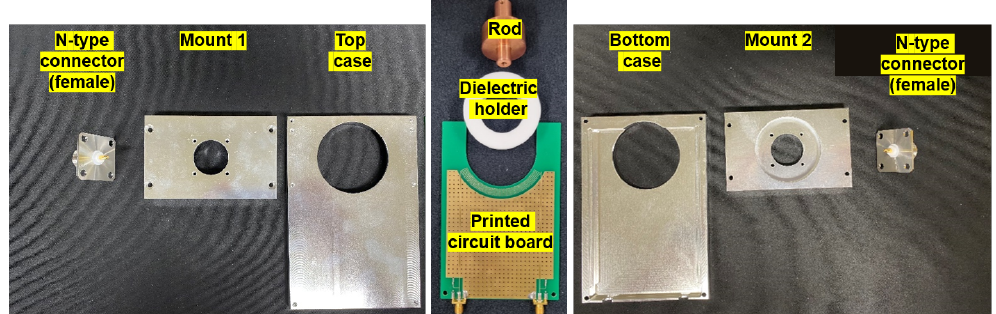
Figure 6. Photographs of the FTC-based VI probe components: N-type connector, mounts, cases, rod, dielectric holder, and PCB.